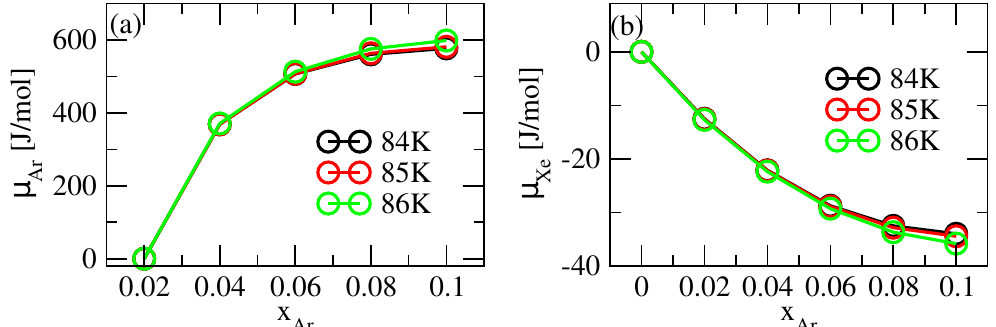
Figure 8. Evolution of the chemical potential of ( a ) Ar and ( b ) Xe as a function of the Ar concentration. Note that the reference point is x Ar =0 for Xe, but it is x Ar = 0.02 for Ar.